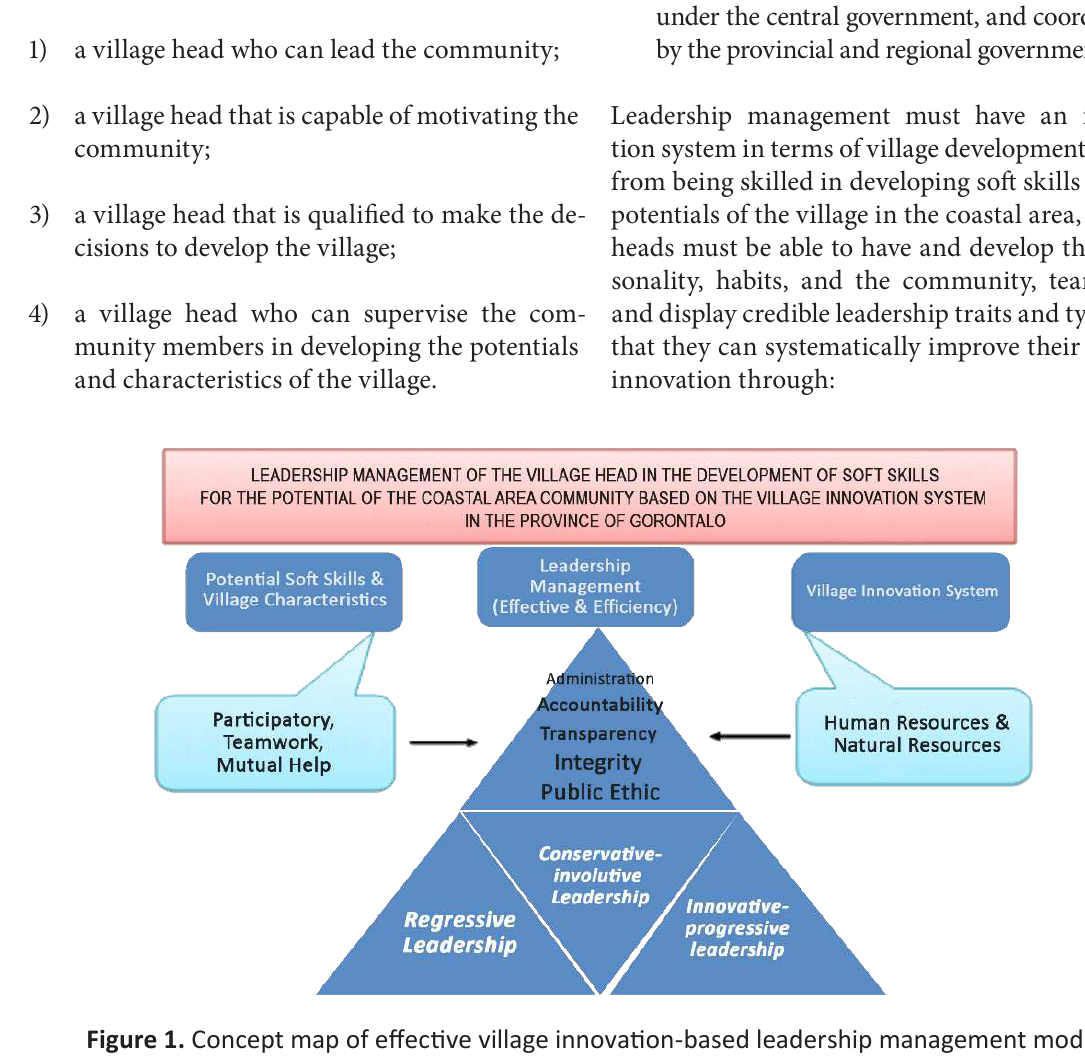
Figure 1. Concept map of effective village innovation-based leadership management